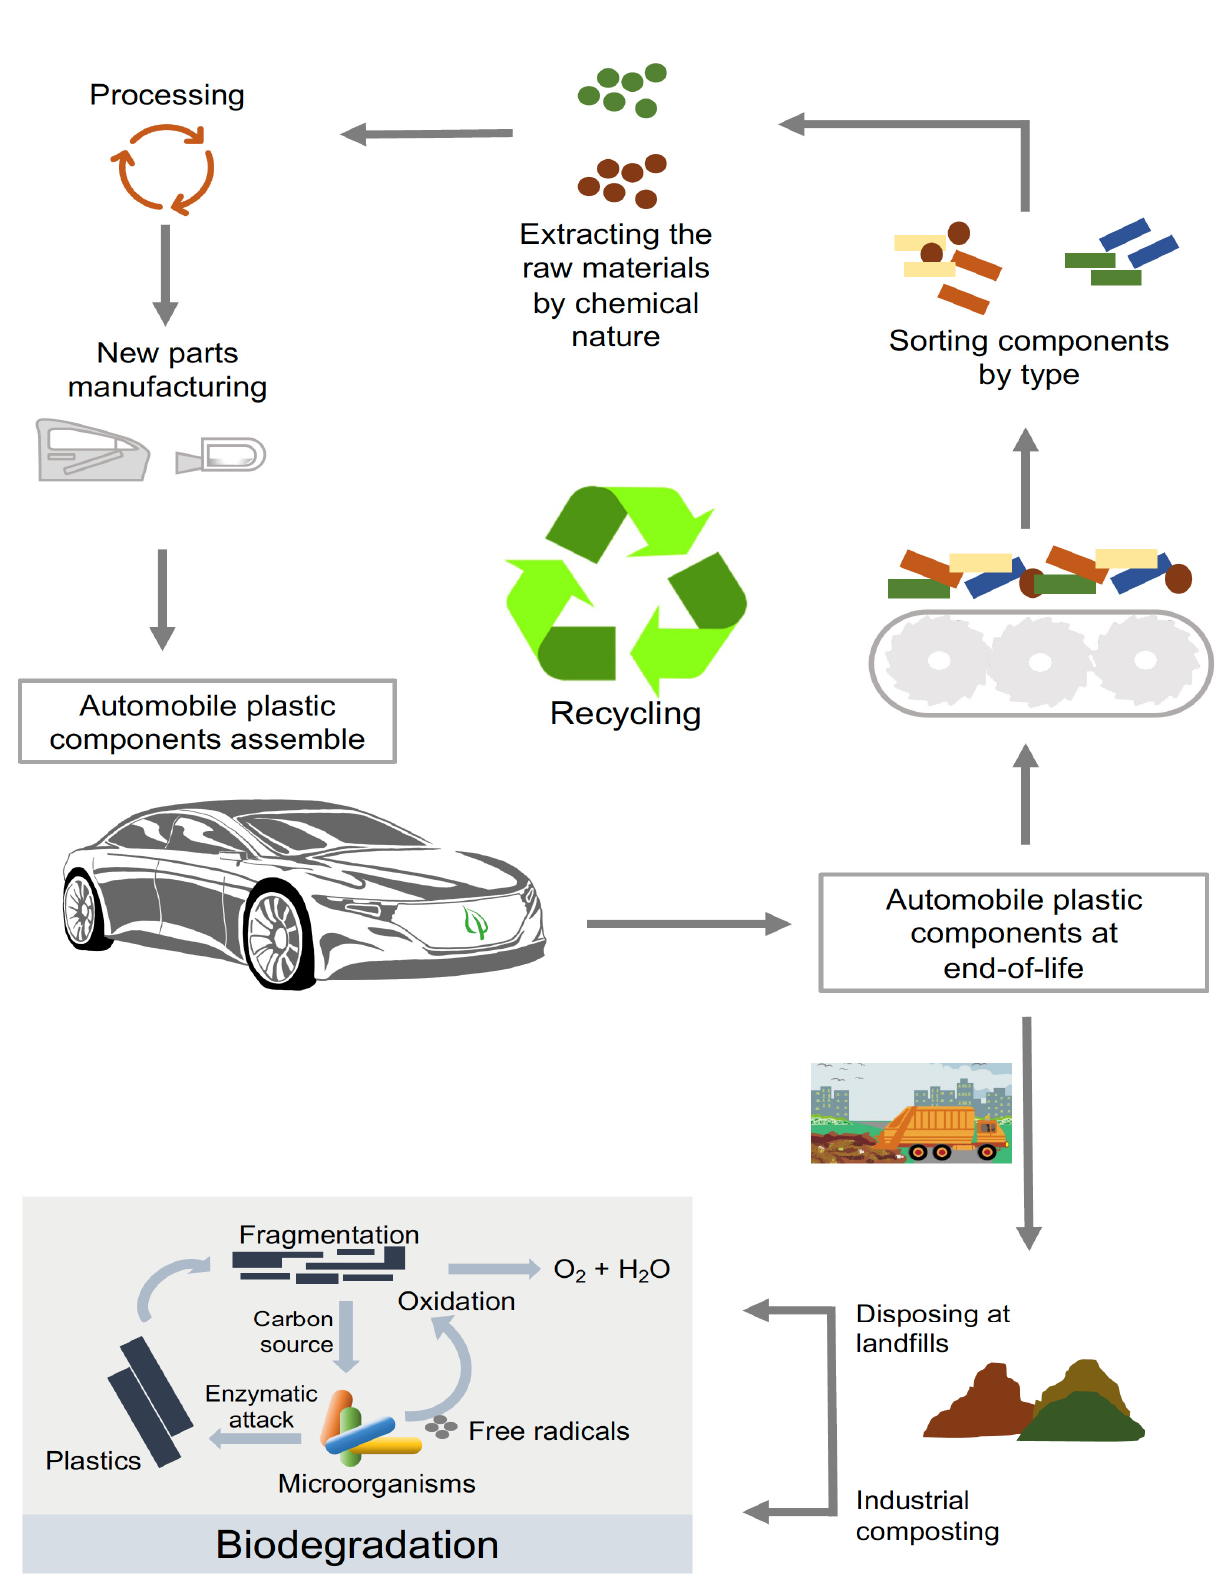
Figure 1. Automobile bioplastic components disposal at end-of-life. Some plastic parts can be recycled, enabling the manufacturer to reuse materials cost-effectively. A plastic disposal program should include one branch of recycling and one of disposing of biodegradable plastics.